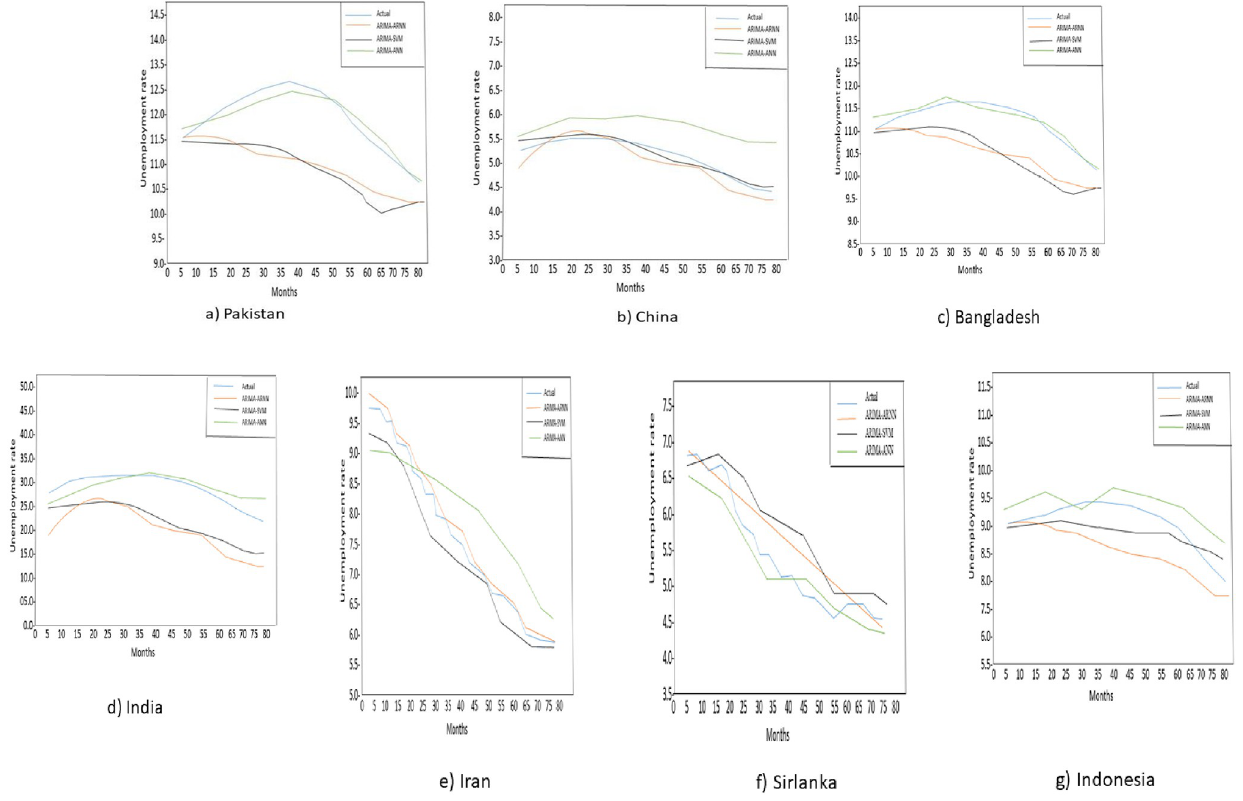
Fig 3. a-g . Prediction of unemployment rate in Asia using selected hybrid